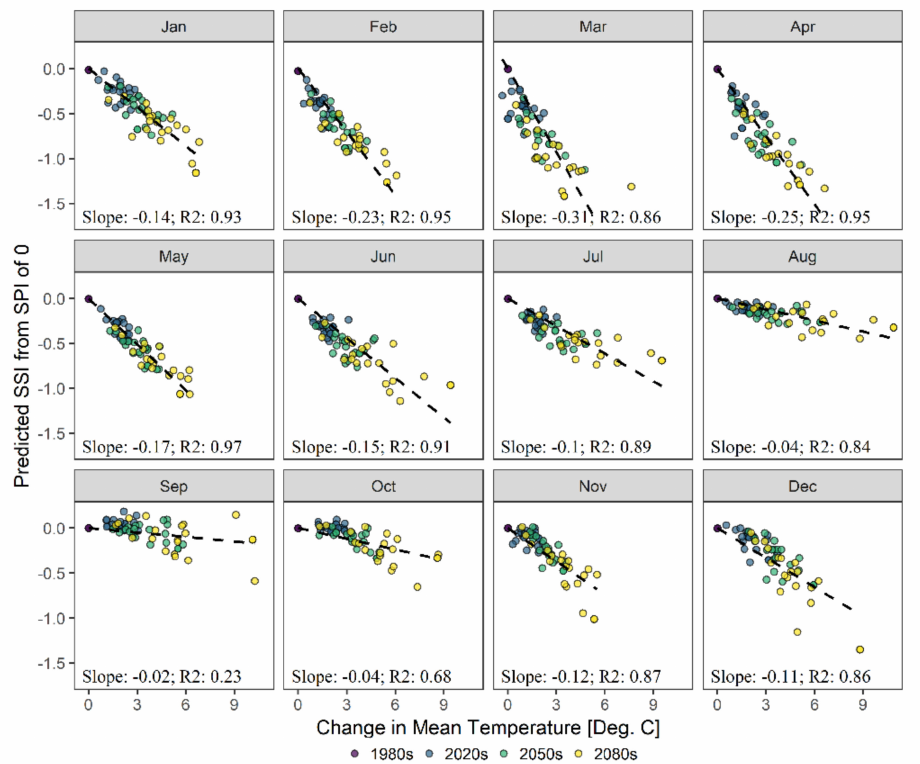
Figure 7. Climate warming impact on the relationship between SPI and SSI. Linear slope represents the change in standardized drought index per ◦ C change in mean monthly temperature. Change in mean temperature is a significant predictor ( p < 0.01) for all